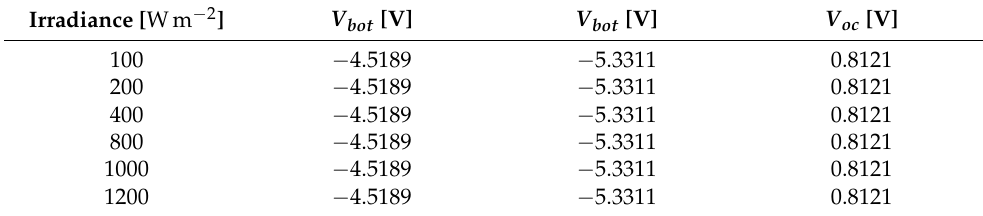
Table 7. Values of the open-circuit voltage with the input